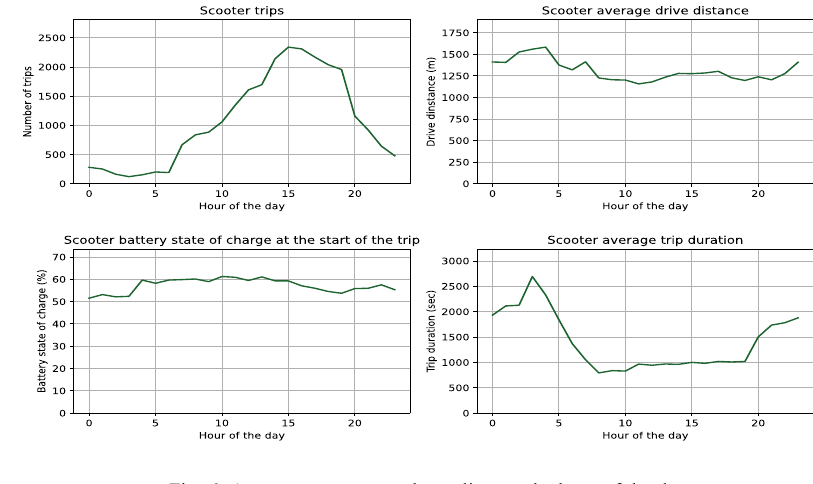
Fig. 6. Average scooter use depending on the hour of the day.